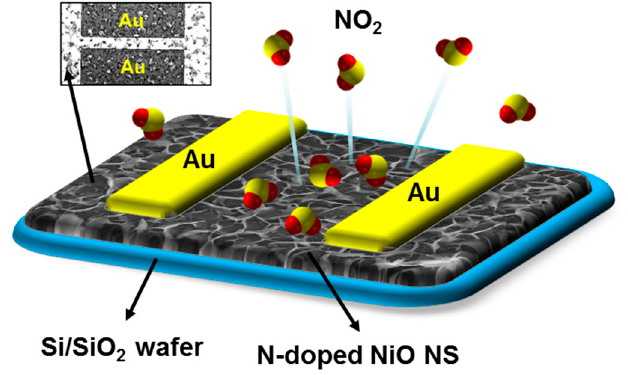
Figure 1. A schematic illustration and a top-view image of a three-dimensional porous N-doped NO 2 gas sensor based on NiO nanosheets